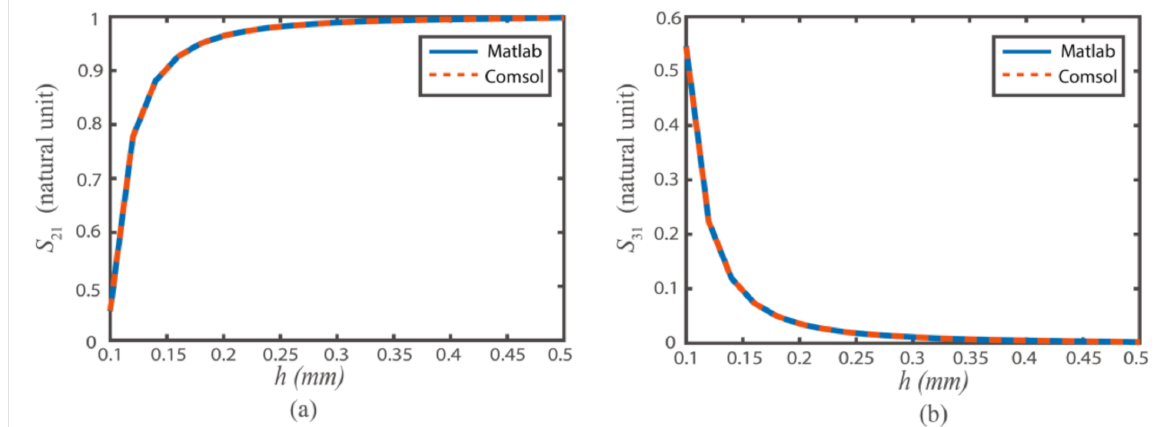
Figure 11. ( a ) Transmission ( S 21 ) and ( b ) reflection ( S 31 ) coefficients of Gaussian fundamental modes with the wire array period h variation.